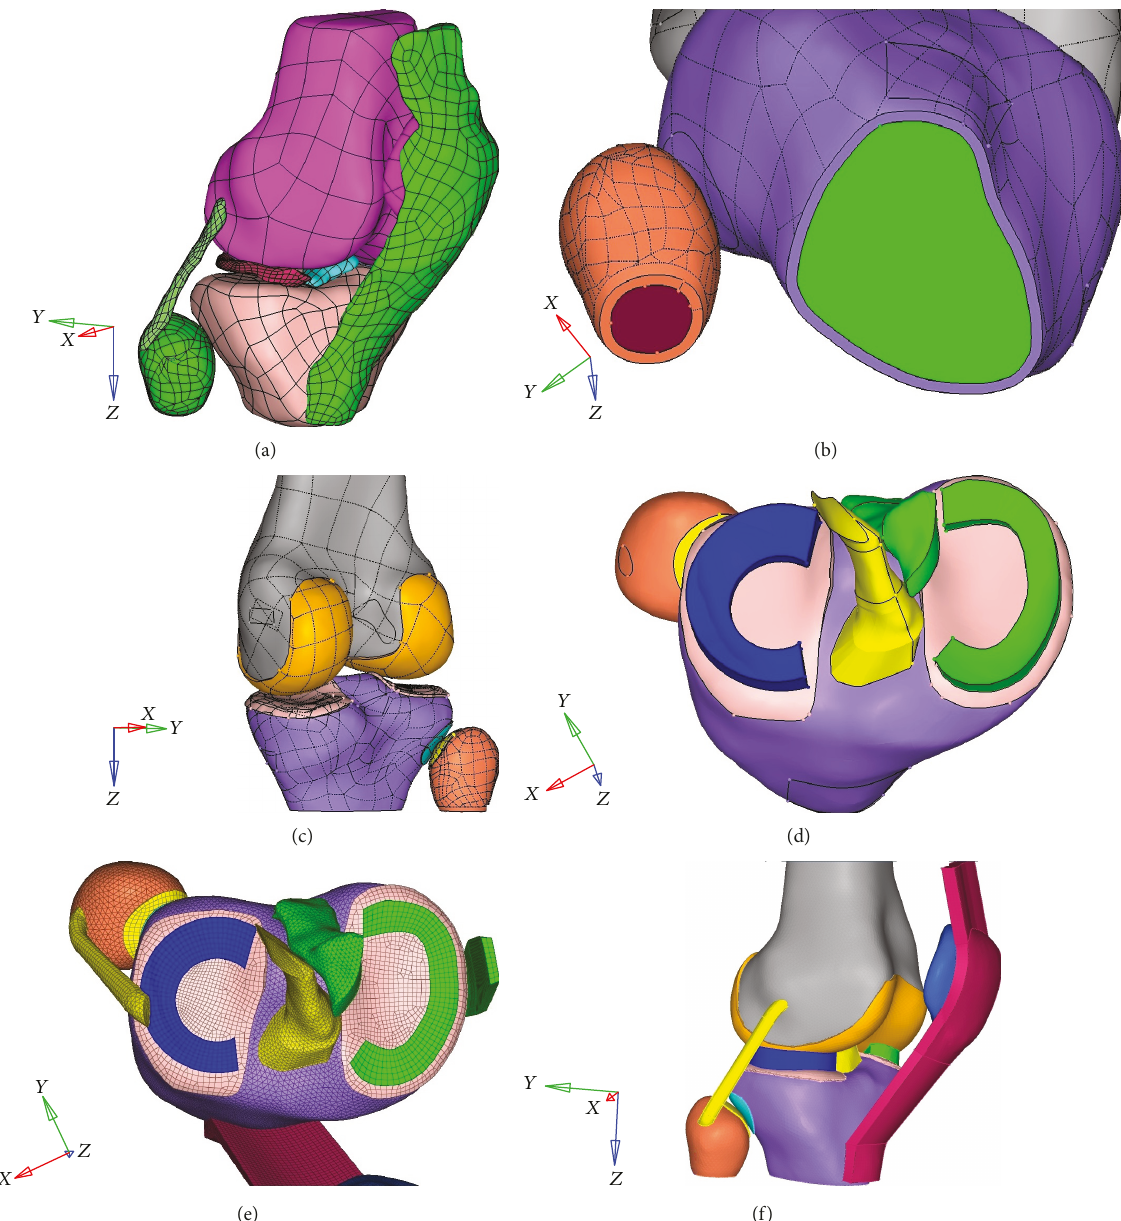
Figure 2: The development of the fi nite element model of the knee joint. (a) Initial inverse knee joint model showing a high-order surface after the smoothing processing. (b) The construction of cancellous bone and cortical bone boundaries; the inward bias of the cortical bone was set at 1.5mm. (c) The articular cartilage thickness of the knee joint was set at 1mm, and the cartilage thickness at the tibio fi bular joint was set at 0.375mm. (d) The reconstructed meniscus and cruciate ligament. (e) The mesh structure of the knee joint. (f) The completed fi nite element model of the knee